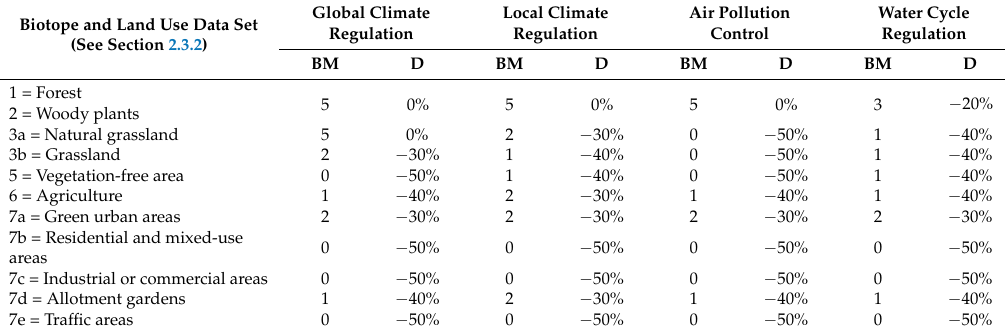
Table 6. The biotope and land use data set classified according to the “Burkhard Matrix” (BM) and its devaluation (D) in our context. Burkhard et al. (2014) [31] classified all biotope and land use types